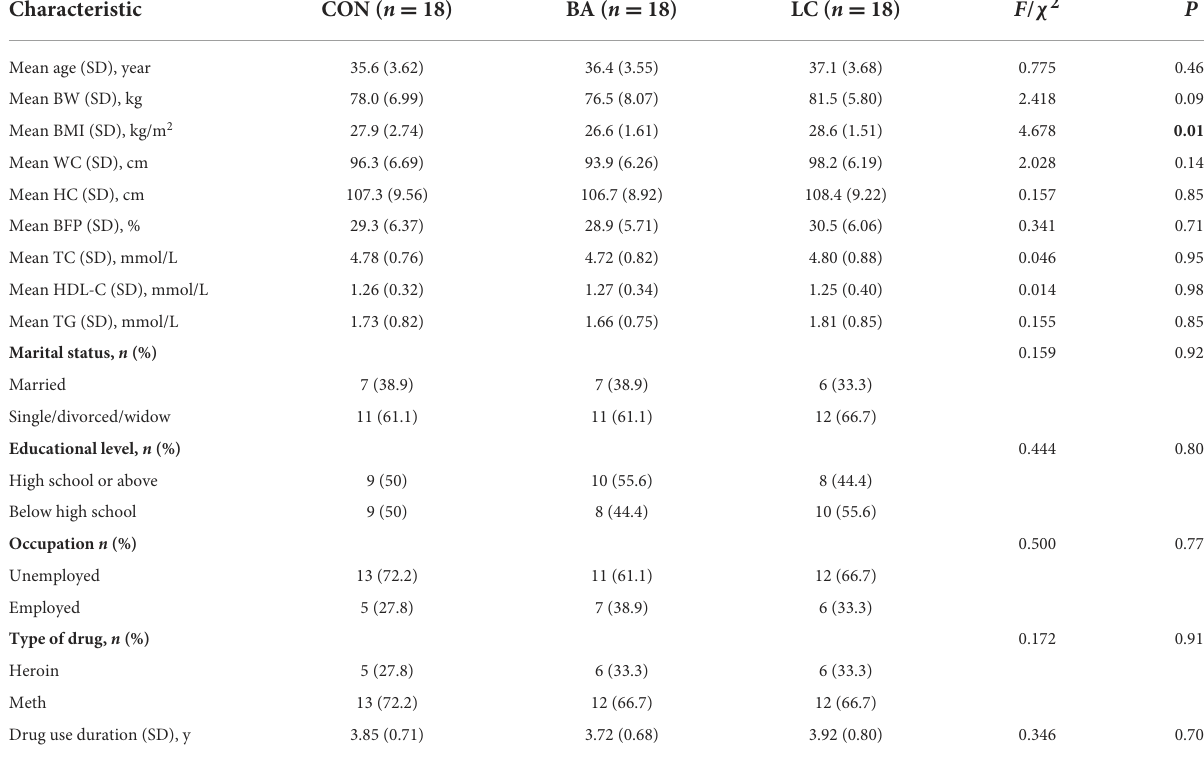
TABLE 1 Demographic data of the participants on admission ( N =